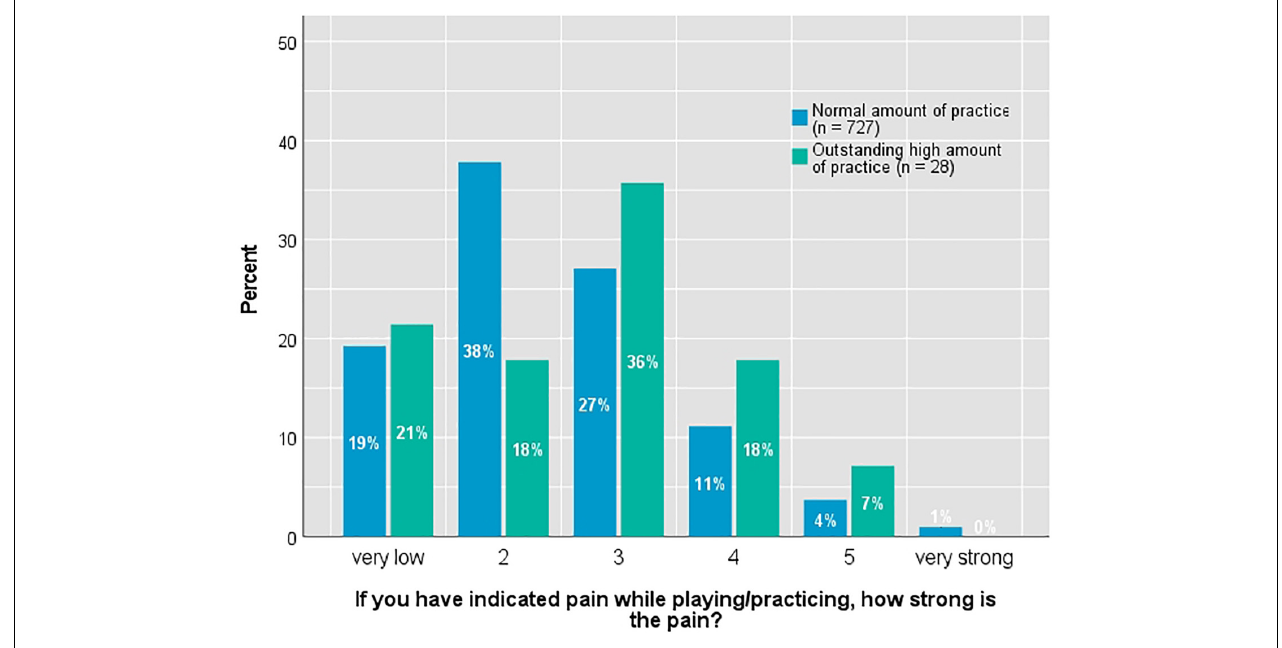
FIGURE 2 | Distribution of pain intensity in differentiation according to amount of